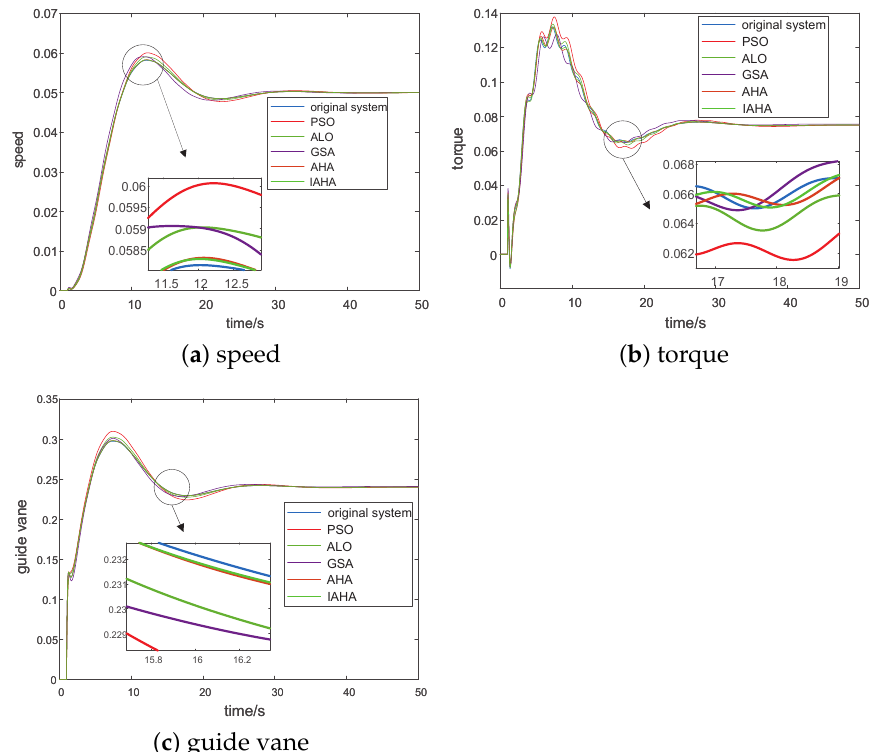
Figure 13. Comparison of the output between different optimization algorithms for 5% frequency disturbance conditions.